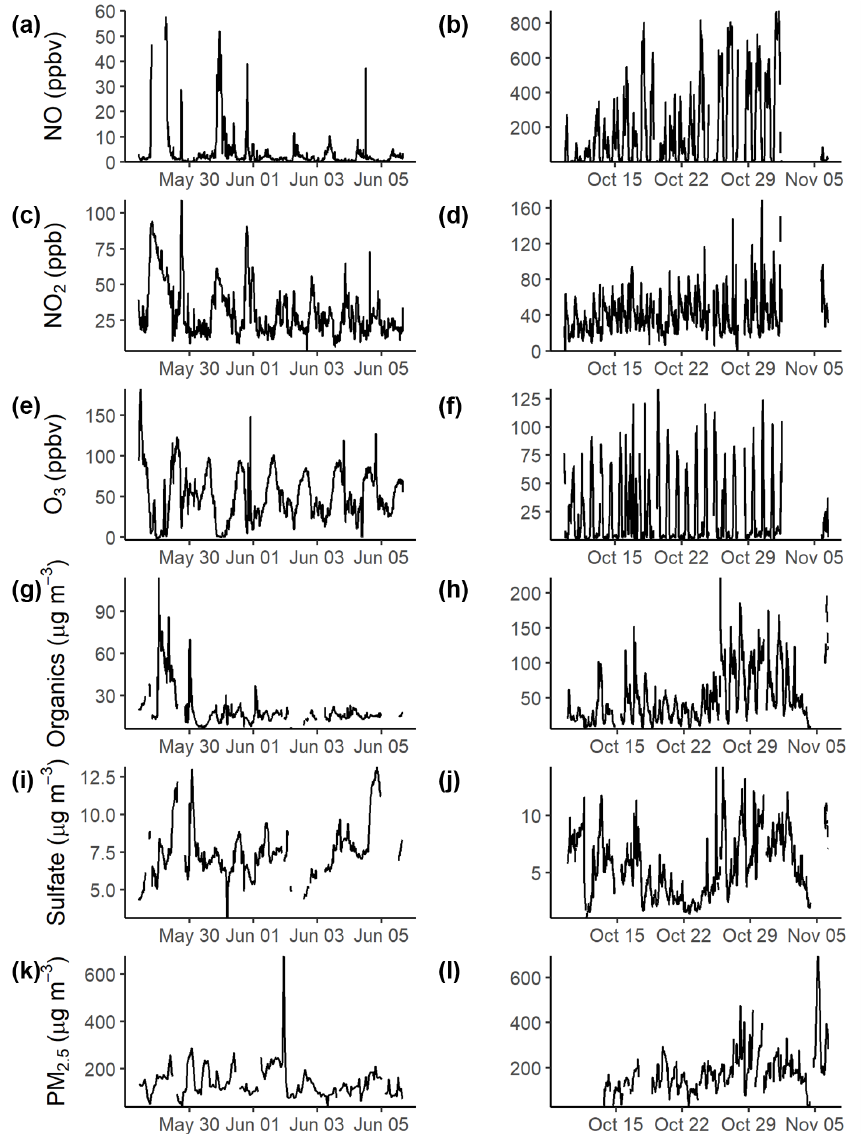
Figure 1. Time series of pollutants across the pre- (a, c, e, g, i) and post-monsoon (b, d, f, h, j) campaigns. During the pre-monsoon, NO concentrations were filtered to below 60ppbv, due to a large enhancement in concentrations at the start of the campaign. The full time series is shown in Fig. S4. NO, NO 2 , O 3 , and HR-AMS–SO 2 − were averaged to 15min. PM 2 . 5 was measured 4